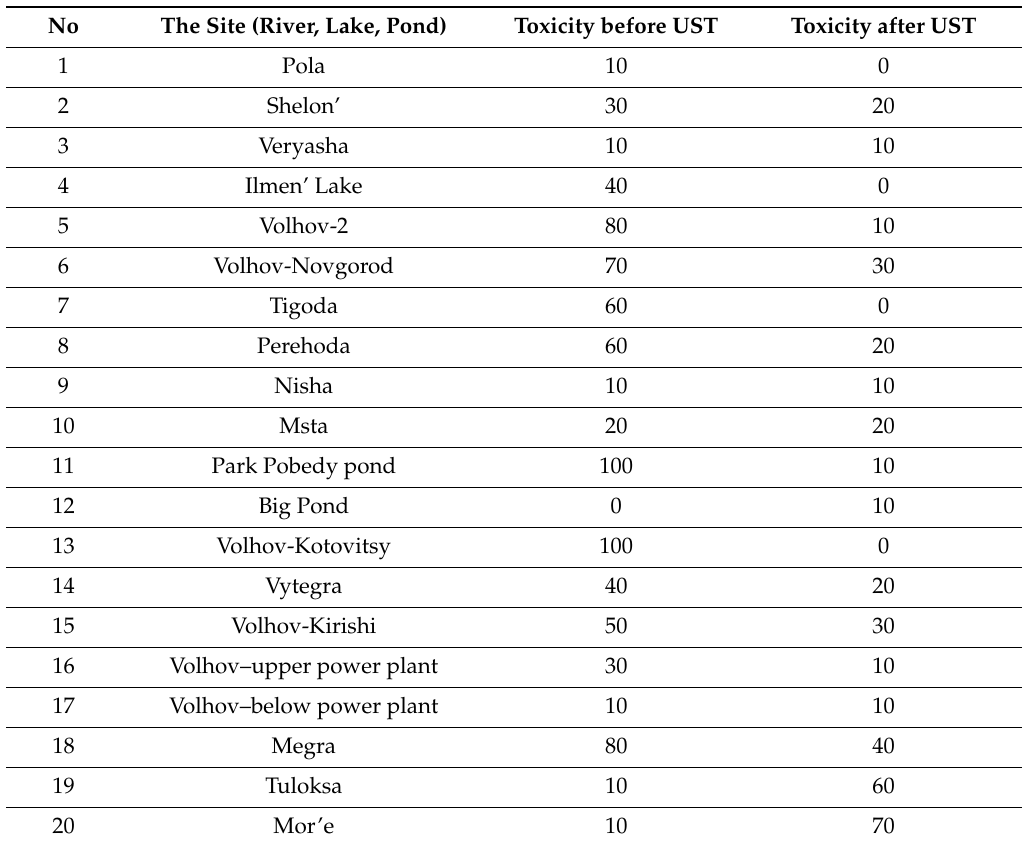
Table 1. Toxicity values of the water samples evaluated by the Daphia magna bioassay before and after ultrasonic treatment (UST).